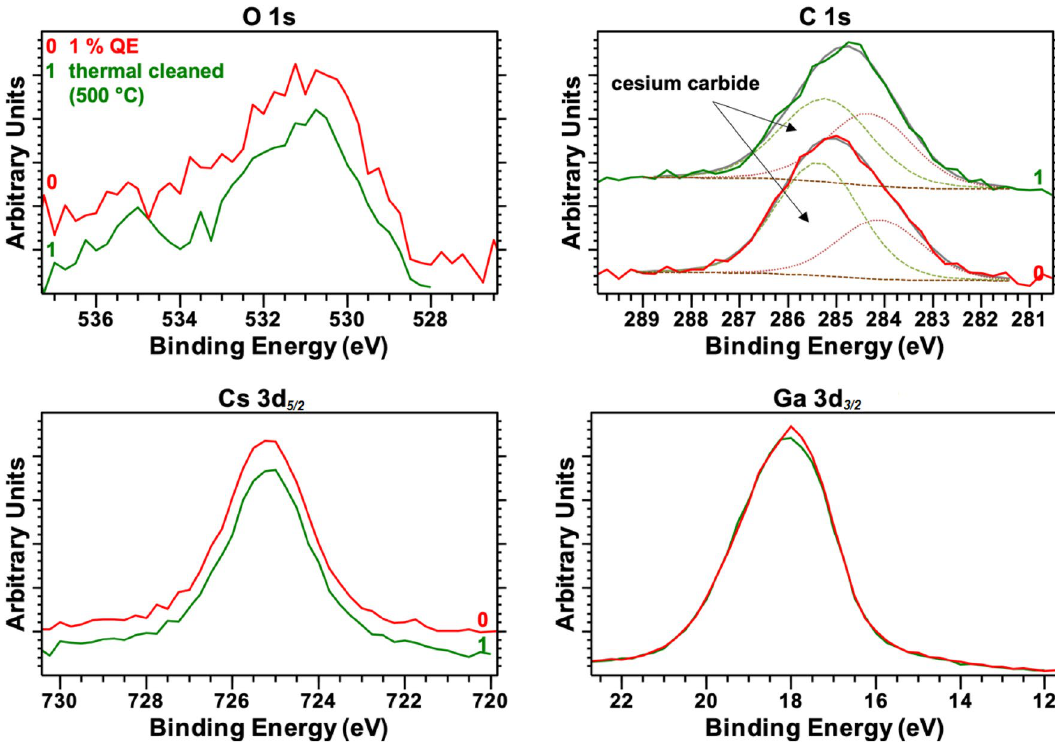
Figure 8. The Ga 3d 3/2 , Cs 3d 5/2 , O 1 s, and C 1 s photoelectron spectra of the p-GaN:Cs surface before (line 0) and after (line 1) renewed thermal cleaning at 500 °C. Dashed lines represent the peak fitting in the C 1 s